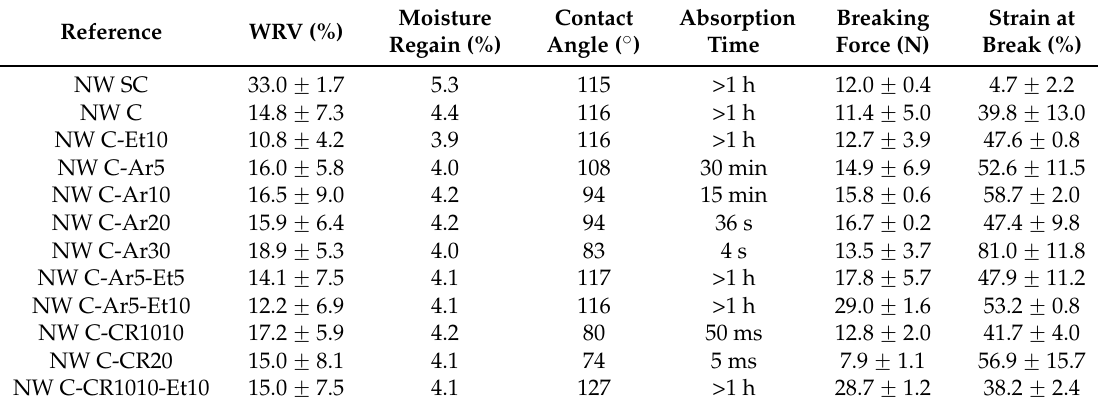
Table 3. Characterization results for